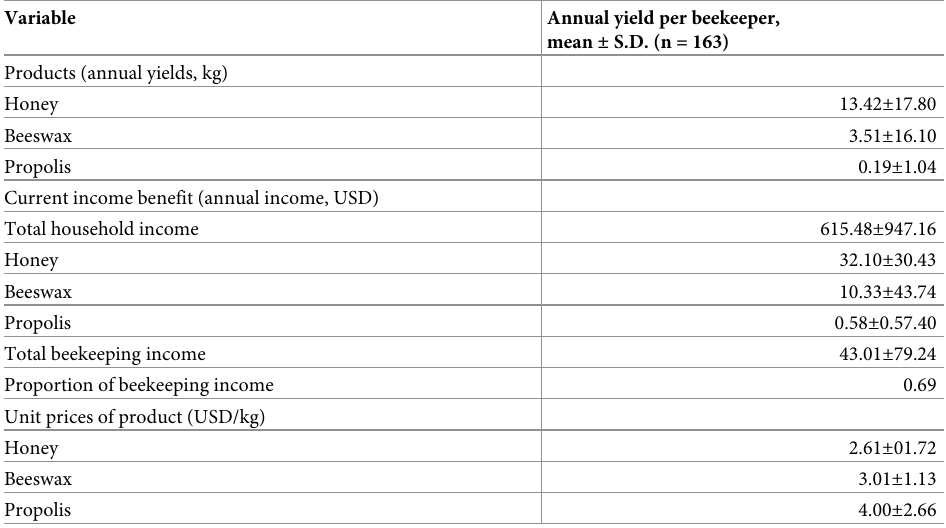
Table 4. Harvested products and unit